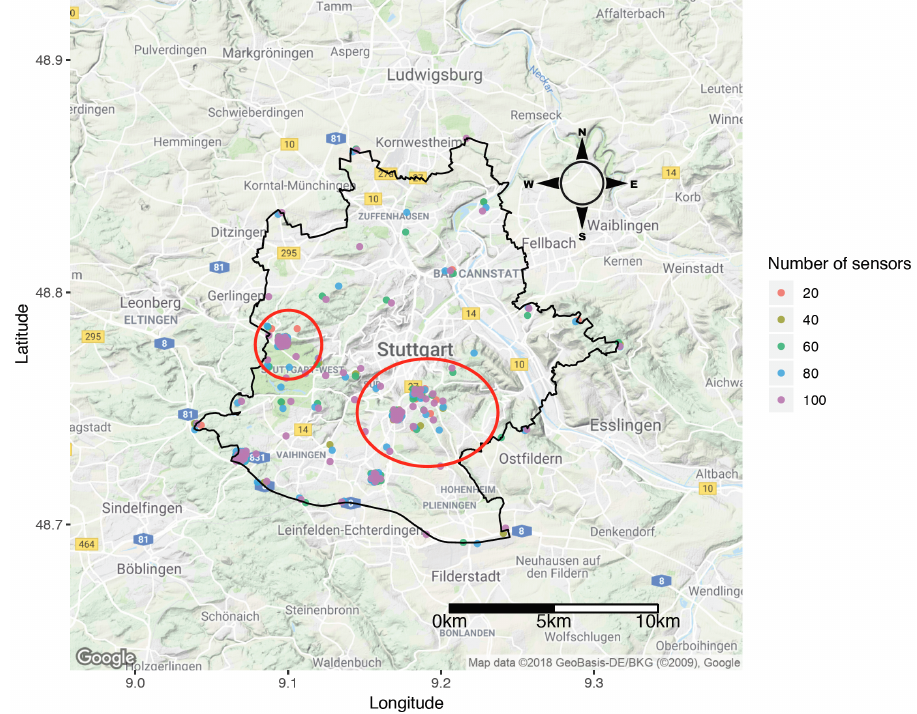
Figure 9. Plot collectively representing all the configurations obtained by running objective function using different numbers of monitoring sensors which can be deployed while initiating a VGI campaign. The red circled areas represent the set of locations that are key to minimise the LUR model prediction